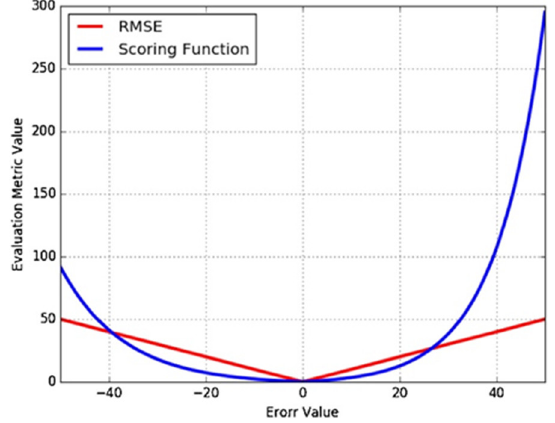
Figure 8. Illustration of the scoring function vs. RMSE.